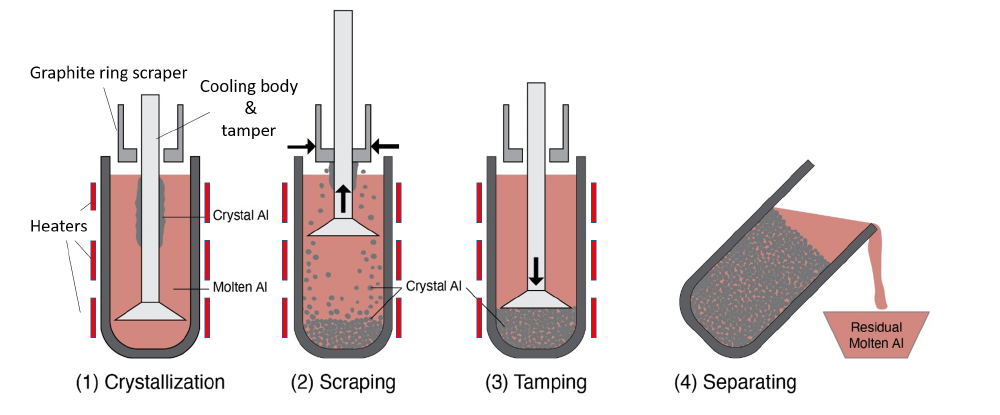
Figure 10. Fractional crystallization sketch of the Pechiney process, as used by Japanese company Kyushu Mitsui Aluminum Co adapted from